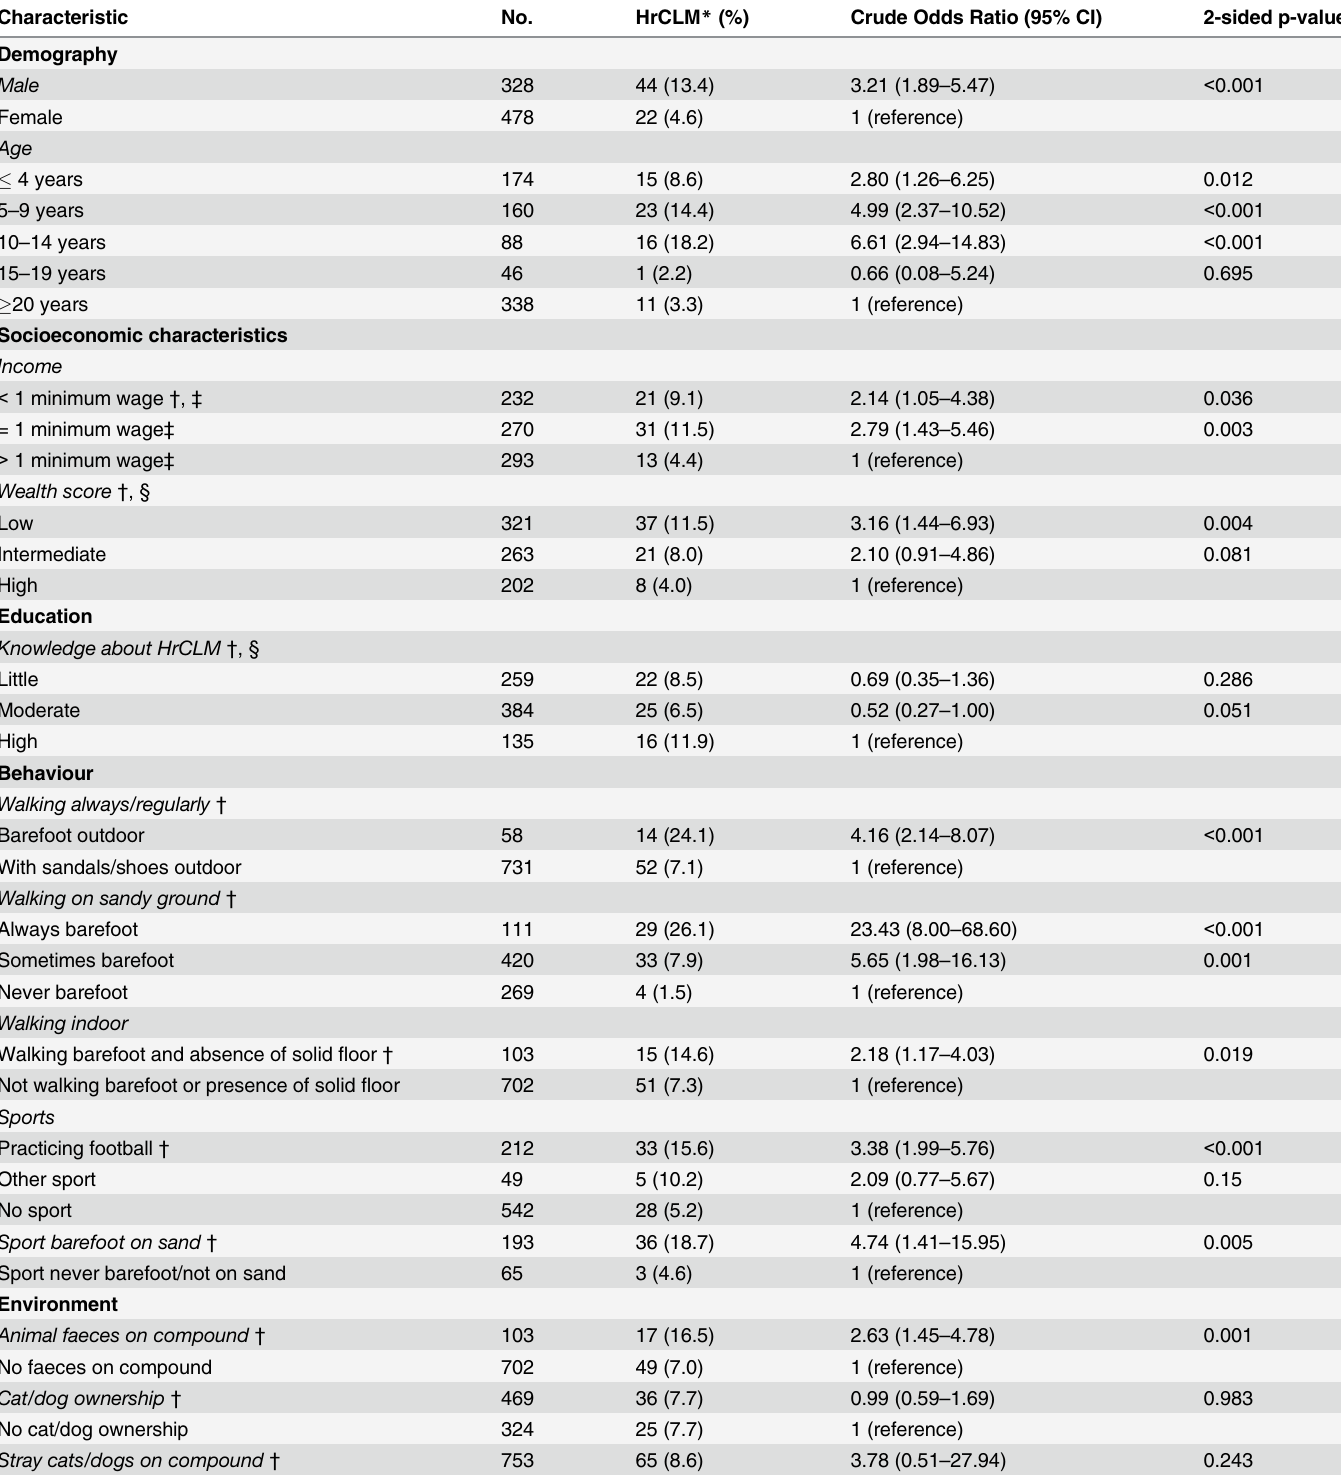
Table 3. Bivariable analysis (N =